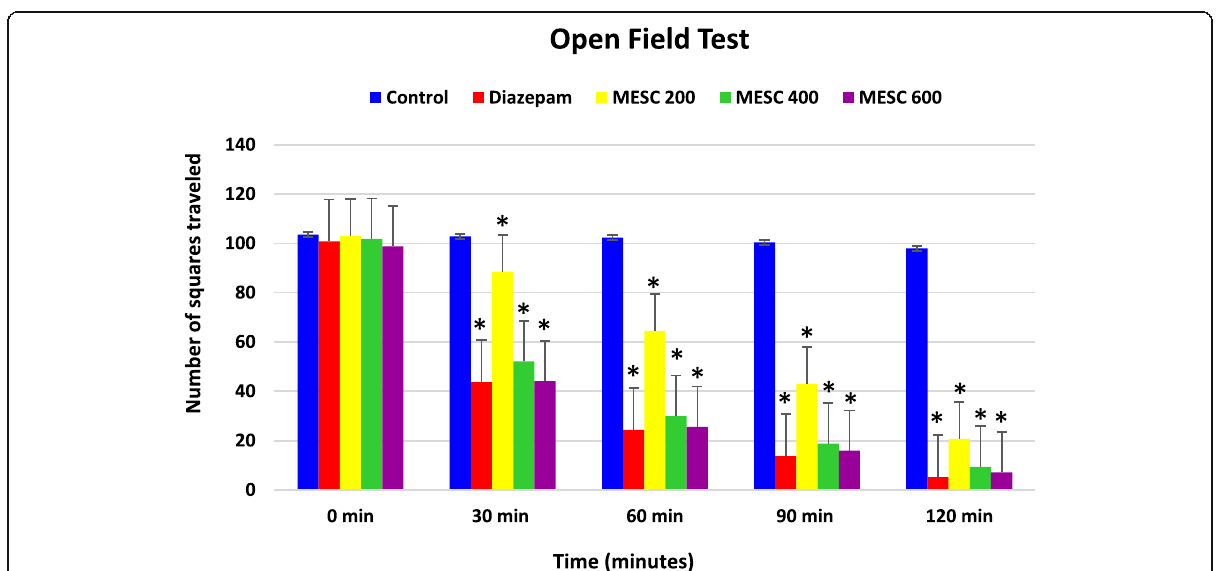
Fig. 1 The sedative effect of MESC on the open field test in mice. i. * p < 0.001 vs control group. ii.** p < 0.0001 vs control group. [Control (NaCl saline 0.1 ml/ mouse), Diazepam (1 mg/kg B.W.), MESC (200, 400 and 600 mg/kg B.W)]